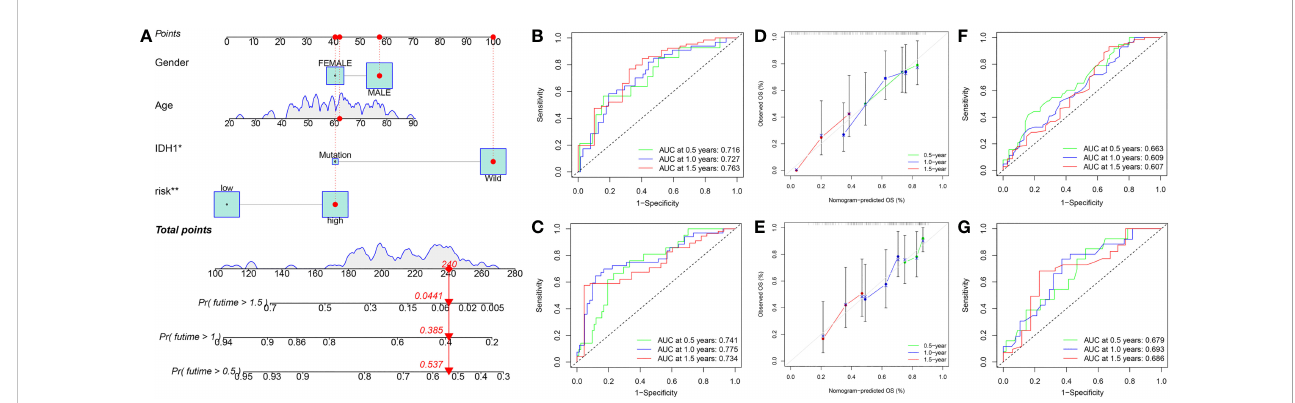
FIGURE 12 Constructed a nomogram in the training set. (A) Nomogram for predicting the 0.5-, 1.0-, and 1.5-year OS of GBM patients in the training set. (B) ROC curves based on the nomogram to predict OS at 0.5-, 1.0-, and 1.5-year in the training set. (C) ROC curves based on the nomogram to predict OS at 0.5-, 1.0-, and 1.5-year in the testing set. (D) Calibration curve of the nomogram to predict 0.5-, 1.0-, and 1.5-year OS in the training set. (E) Calibration curve of the nomogram to predict 0.5-, 1.0-, and 1.5-year OS in the testing set. (F) ROC curves based on IDH1 mutation status to predict OS at 0.5-, 1.0-, and 1.5-year in the training set. (G) ROC curves based on IDH1 mutation status to predict OS at 0.5-, 1.0-, and 1.5-year in the testing set. OS, overall survival; ROC, receiver operating characteristic.